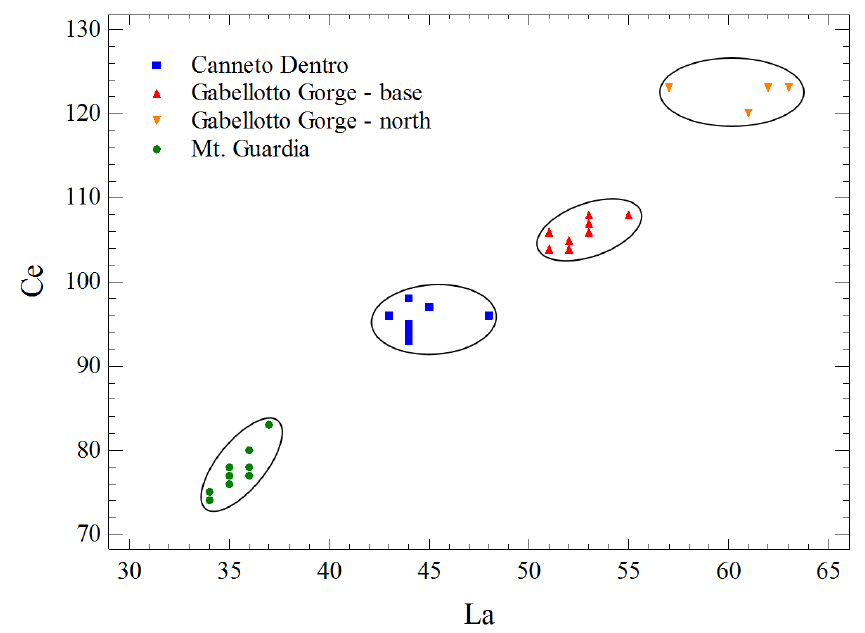
Figure 11. X-Y graph of Lipari subsources using INAA on trace elements lanthanum and cerium. Laser ablation ICP mass spectrometry was performed on 213 geological samples, including 49 of prehistoric age. Multi-variate discriminant function statistical analysis clearly distinguishes not only the prehistoric subgroups of Monte Guardia, Gabellotto (base and north), and Canneto Dentro, but also the historic Forgia Vecchia and Rocche Rosse subsources (Figures 12–13).